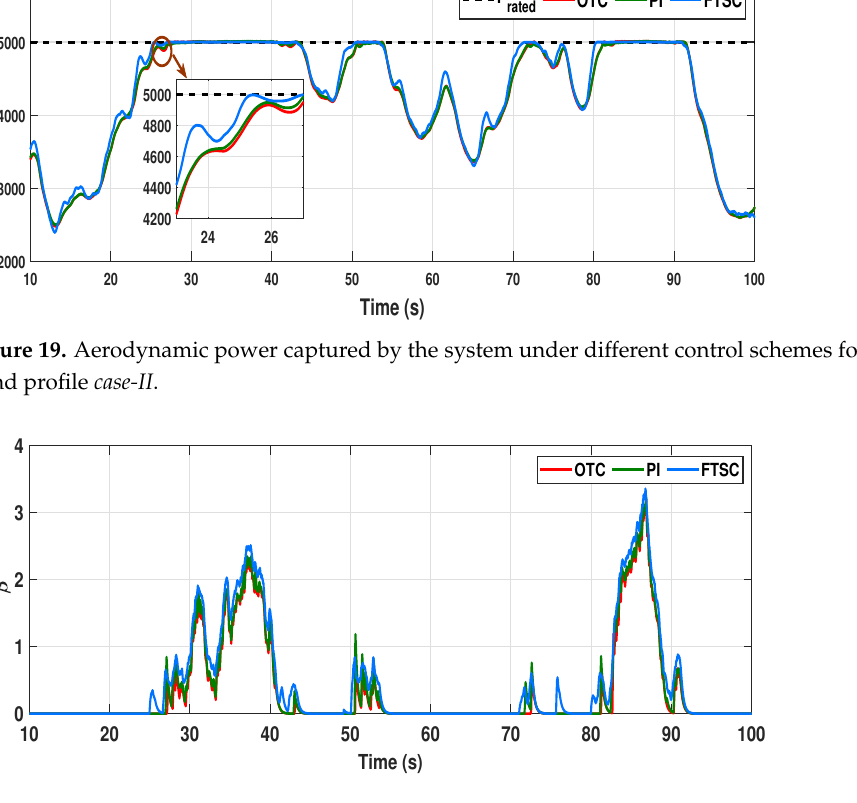
Figure 20. The pitch angle ( β ) regulation signal given to the actuator for region III operation under varying wind profile case-II with different control